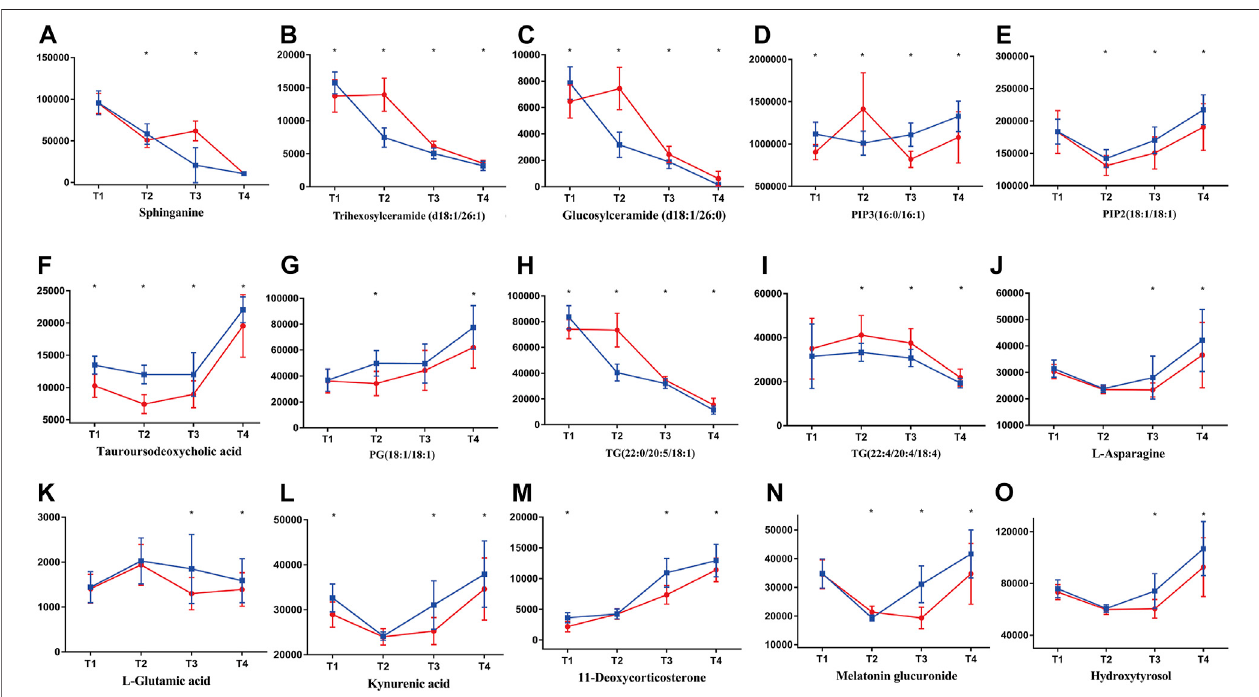
FIGURE8| Typicalmetaboliteswithsigni fi cantchangesinAHsubgroup.Linesinblue( )representZYPgroupwhileinred( )representplacebogroup.Contentsof metabolites were assessed with t test between ZYP and placebo group. Contents of metabolites are shown in this fi gure, i.e., (A) sphinganine, (B) trihexosylceramide (d18:1/26:1), (C) glucosylceramide(d18:1/26:0), (D) PIP3(16:0/16:1), (E) PIP2(18:1/18:1), (F) tauroursodeoxycholicacid, (G) PG(18:1/18:1), (H) TG(22:0/20:5/18:1), (I) TG(22:4/20:4/18:4), (J) L-asparagine, (K) L-glutamic acid, (L) kynurenic acid, (M) 11-deoxycorticosterone, (N) melatonin glucuronide, (O) hydroxytyrosol. * p < 0.05 were regarded as statistically signi fi cant, compared with placebo